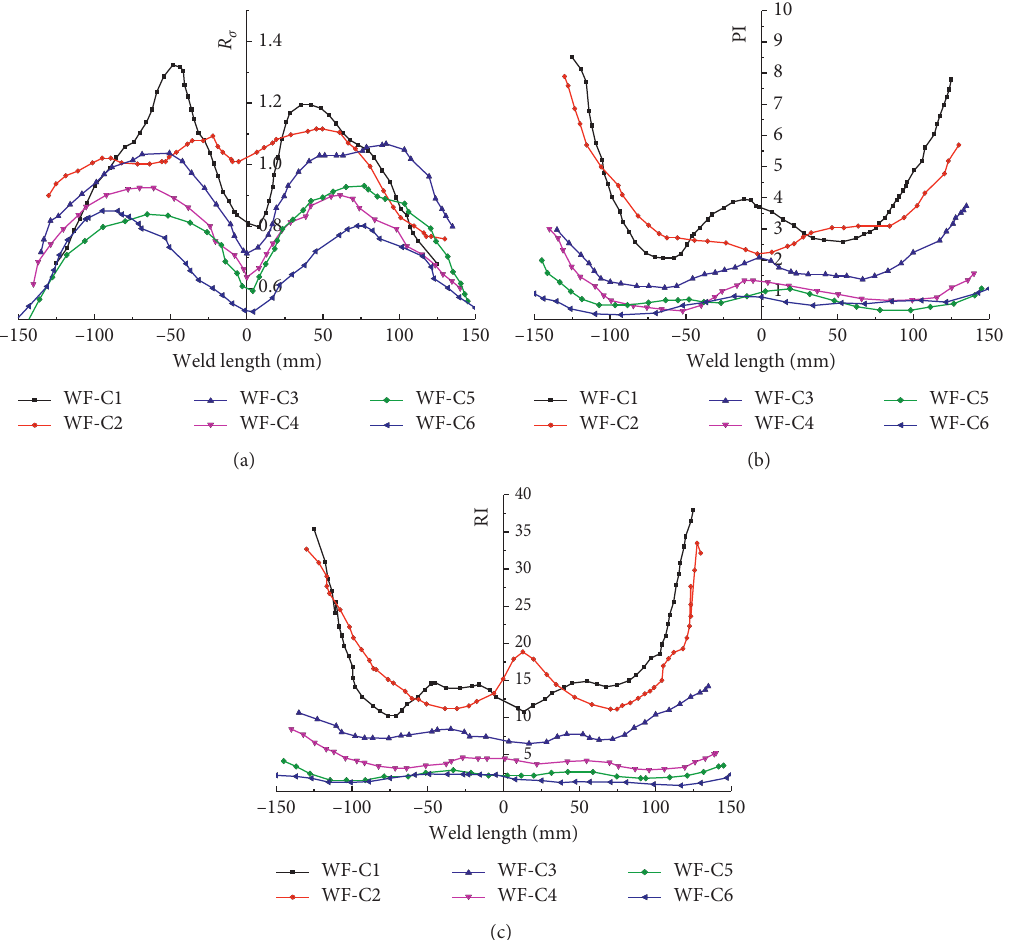
Figure 11: WF-C. (a) Triaxiality ratio. (b) Equivalent plastic strain index. (c) Cracking